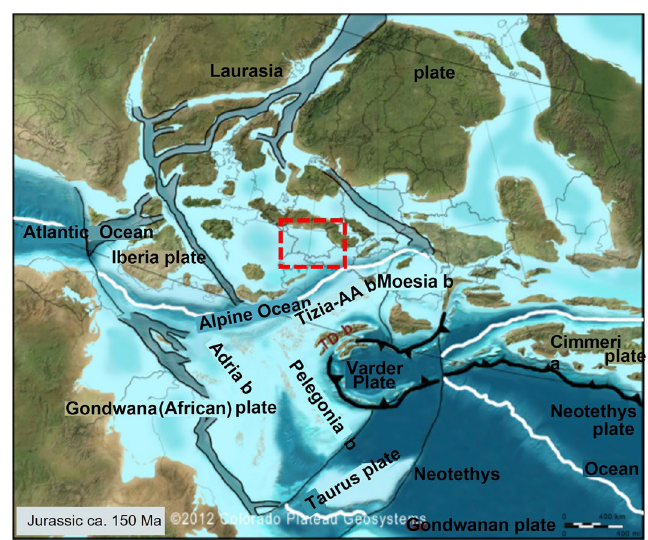
Fig. 2 Detail view of the Late Jurassic showing the northern edge of the Tethys ocean, the opening of the Central Atlantic Ocean, and the surrounding landmasses (Blakey 2015). During the Upper Jurassic, up to 600-m-thick carbonates were deposited in South Germany, with a simplified North-East/South-West proximal–distal